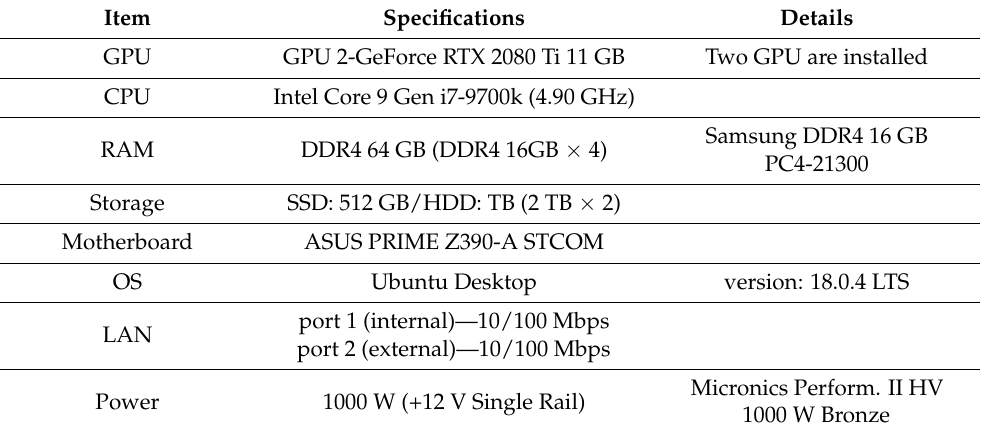
Table 2. The environment of the artificial intelligence server.